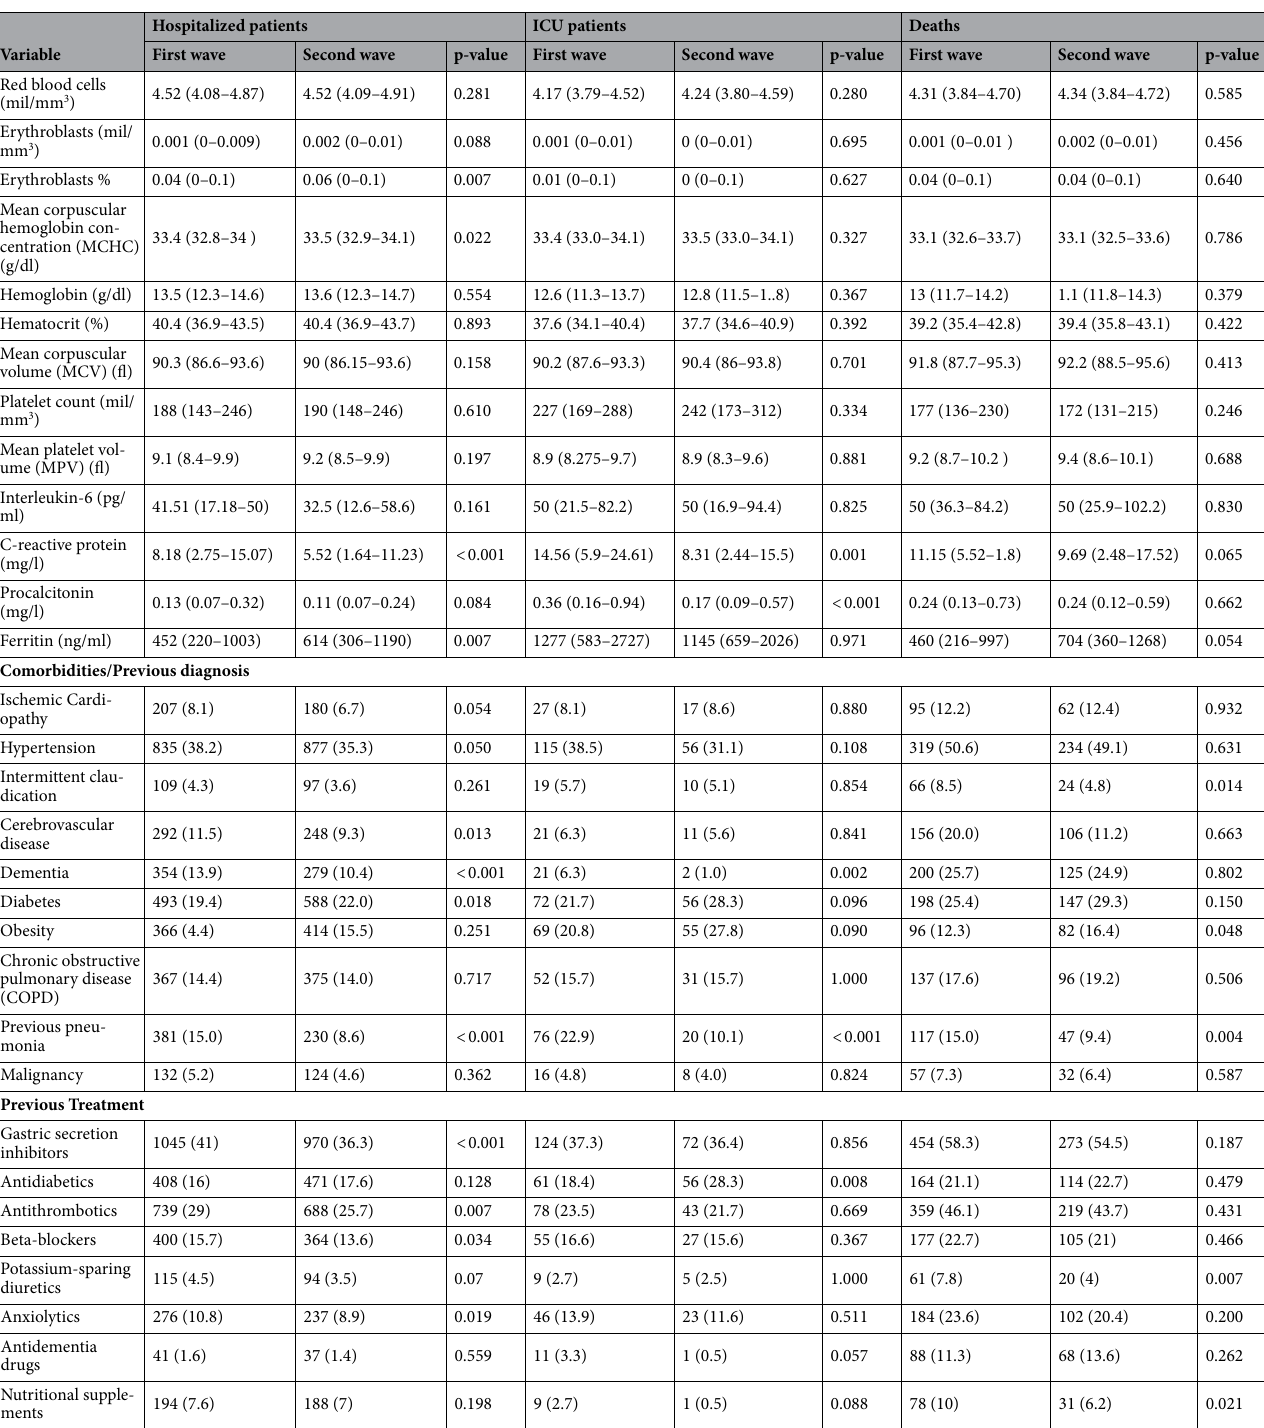
Table 1. Comparisons of clinical and laboratory variables between the two COVID-19 pandemic waves, Aragon, Spain, February–September 2020. ICU: intensive care unit; IQR: interquartile range; NA: not applicable. Patients were grouped as hospitalized patients (total number of patients), admitted to the ICU, and deceased. Laboratory and clinical variables were baseline values and are presented as the median and interquartile range (IQR). Units are shown in parentheses. Values of sex, comorbidities and previous treatment are displayed as n and the percentage of total patients